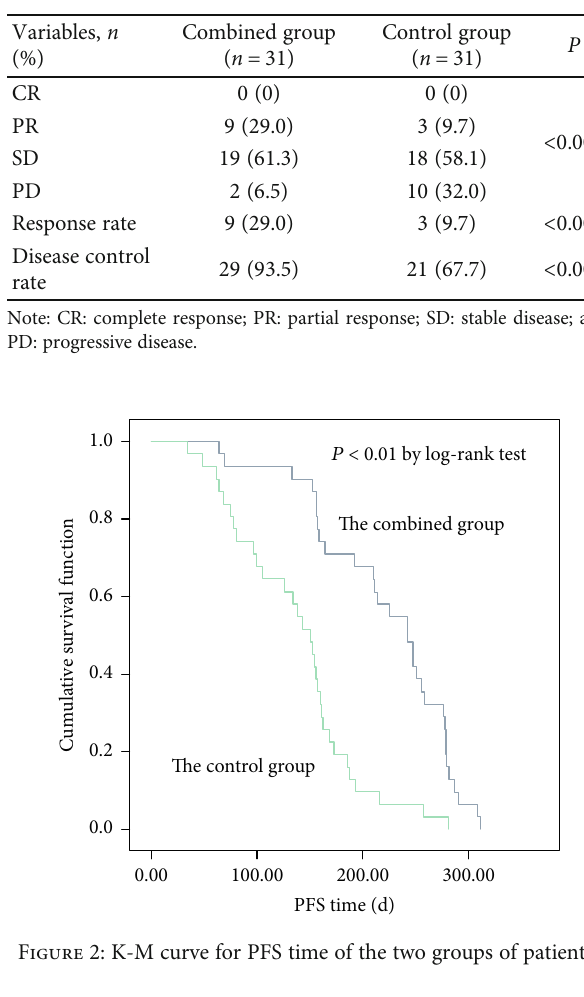
Table 2: Treatment e ffi cacy and survival condition for all patients.